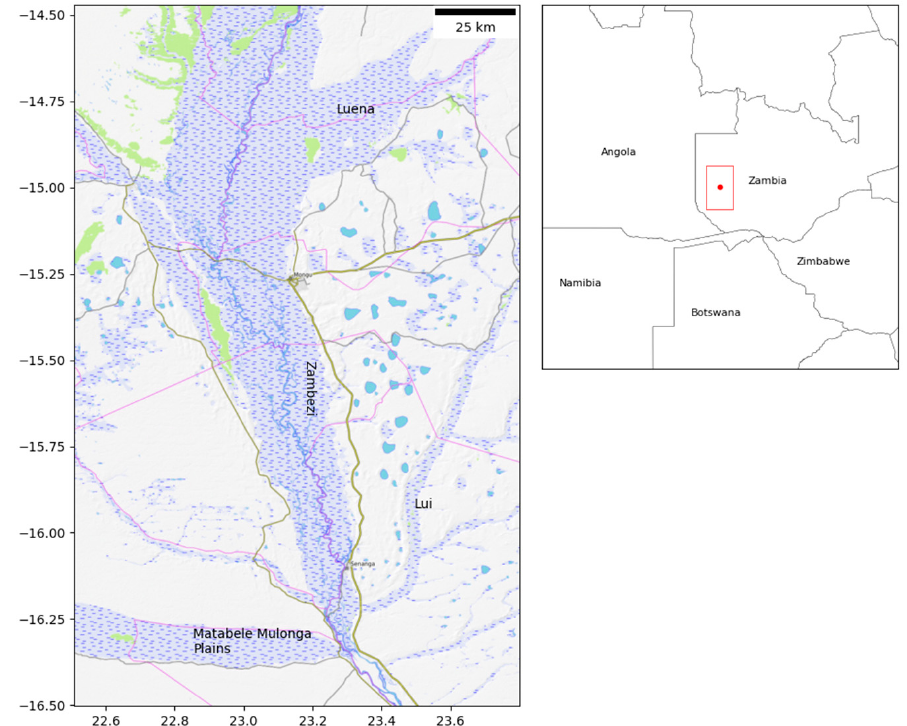
Figure 1. Open TopoMap showing the location of the Barotseland Floodplain study site within western Zambia (highlighted with red square and point), with the main Zambezi Channel highlighted as well as the Leuna, Lui and Matabele Mulonga tributaries marked.